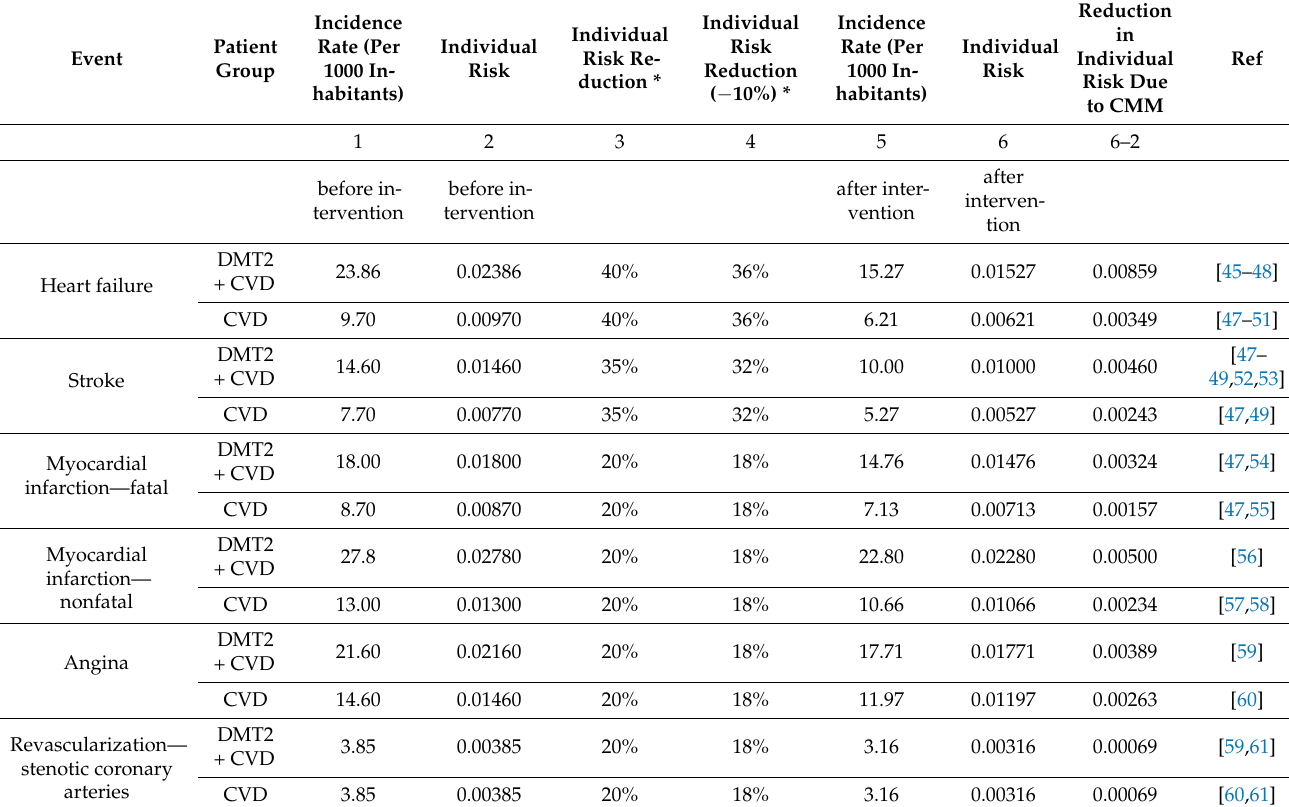
Table 5. Risk reduction and incidence rates of unwanted clinical